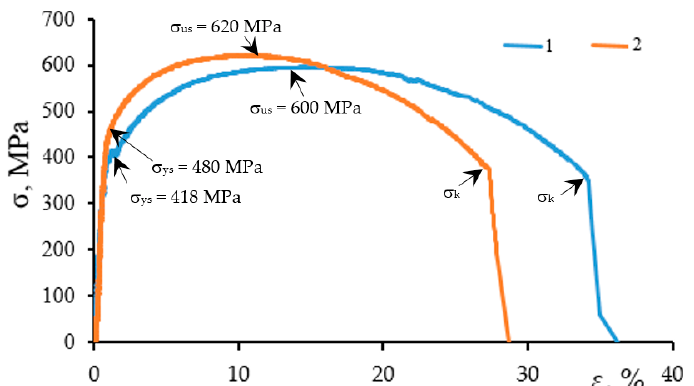
Figure 4. Complete stress–strain diagrams for steel specimens taken from the gas pipelines: 1—“Novopskov-Aksay-Mozdok” (Nevinnomysskaya CS); 2—“Gorky-Center” (Gavrilovskaya CS); σ k —is the stress acting on the specimen at the start of propagation of the macrocrack.